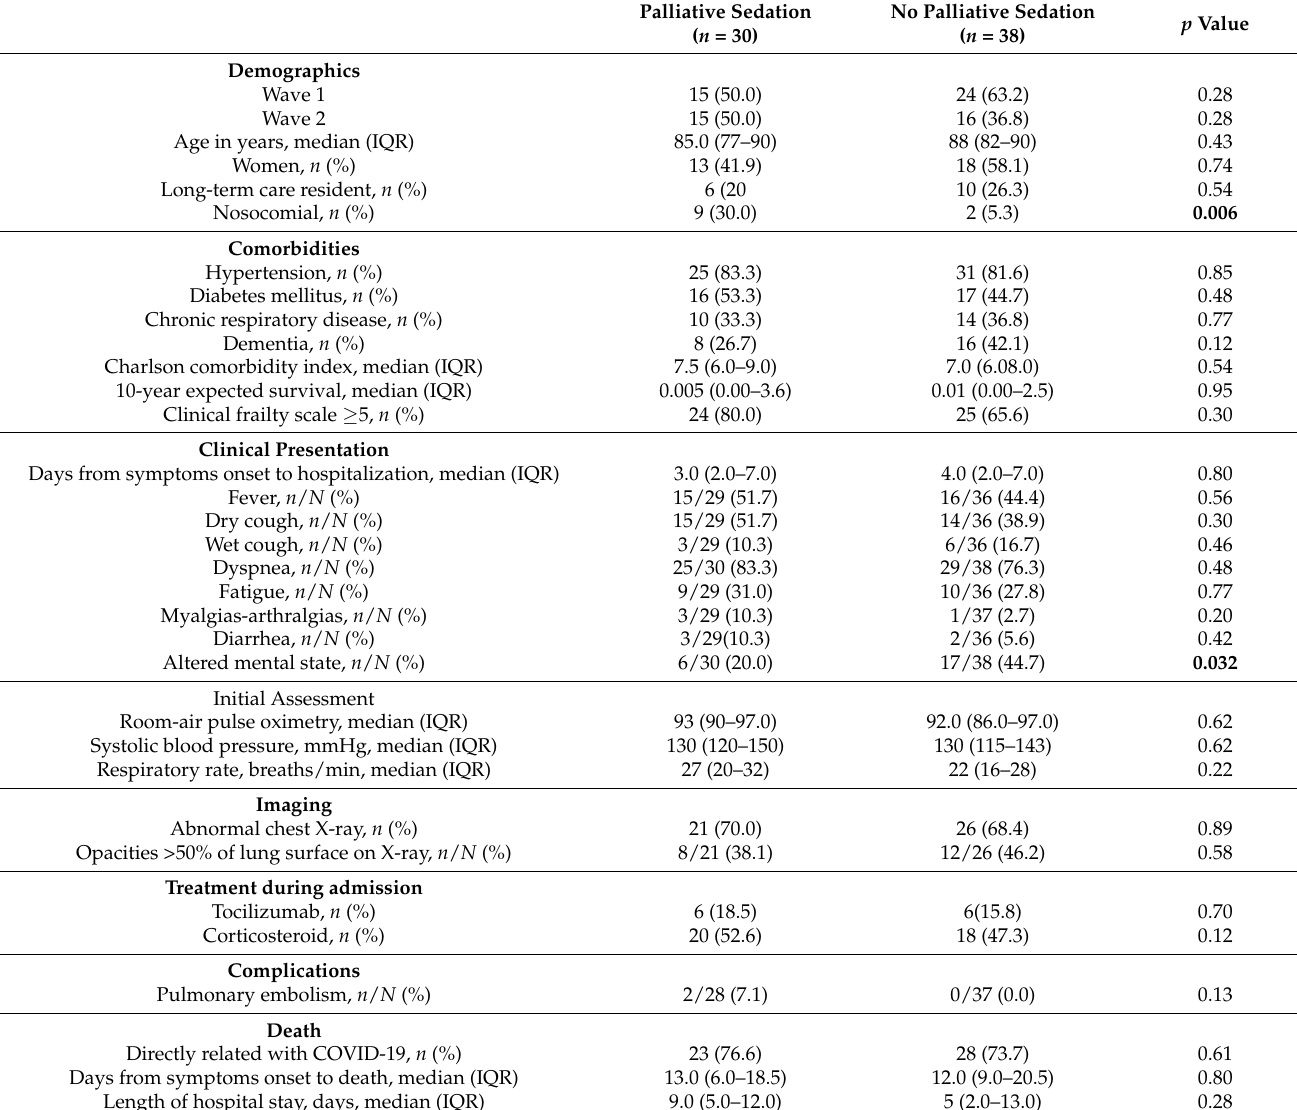
Table 1. Demographic characteristics, comorbidities, and clinical presentation according to the administration of palliative sedation, in inpatients with COVID-19 in an acute medical